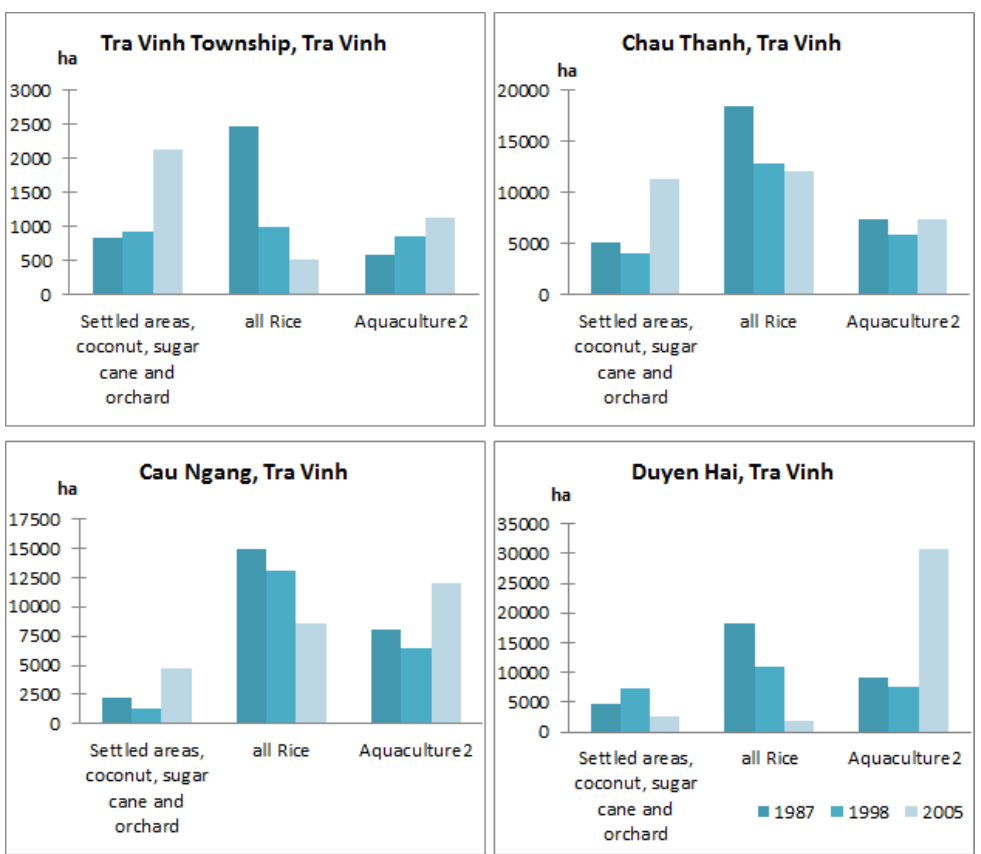
Figure 8. The SPOT results (1987, 1998, 2005) for four districts in Tra